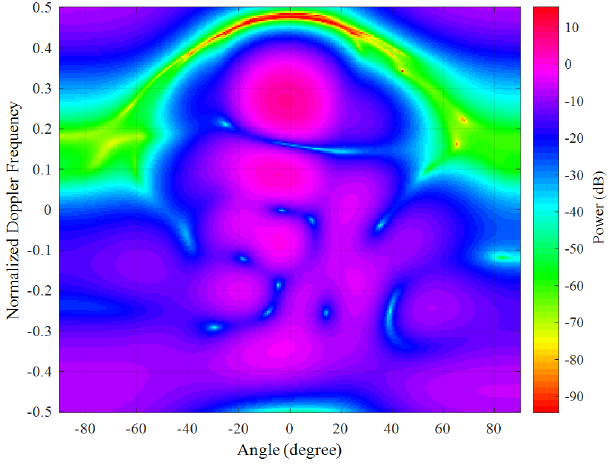
Figure 11. Weight vector response after adaptive Doppler compensation.